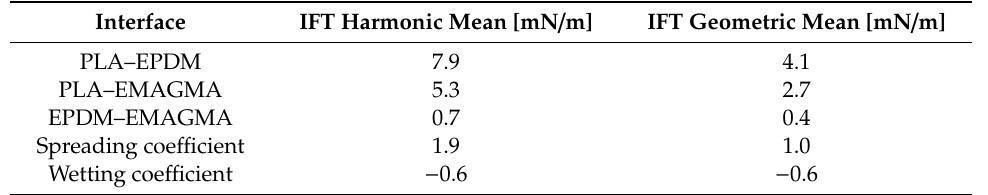
Table 3. Calculated Interfacial Tensions (IFT), Spreading Coe ffi cients, and Wetting Coe ffi cients of the Used